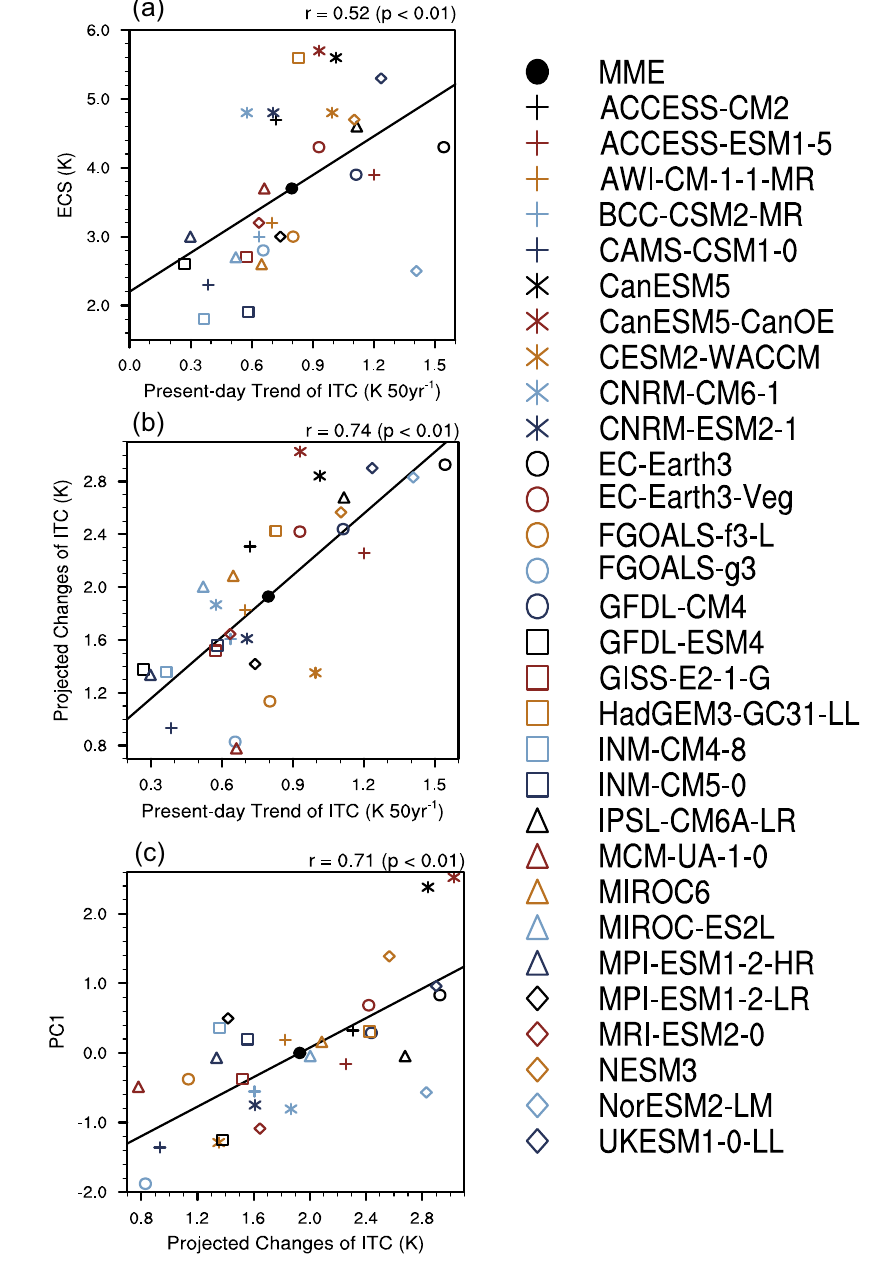
Fig. 3 Inter-model physical relationship between the present-day and projected spread. a – c inter-model relationship among the equilibrium climate sensitivity (ECS), present-day trend of interhemispheric thermal contrast (ITC), projected changes of ITC and PC1. The de fi nition of the indices above is in Methods. Solid fi tting line is obtained by the least square method. The results on the top-right corner are the correlation coef fi cient and signi fi cant level under Student ’ s t